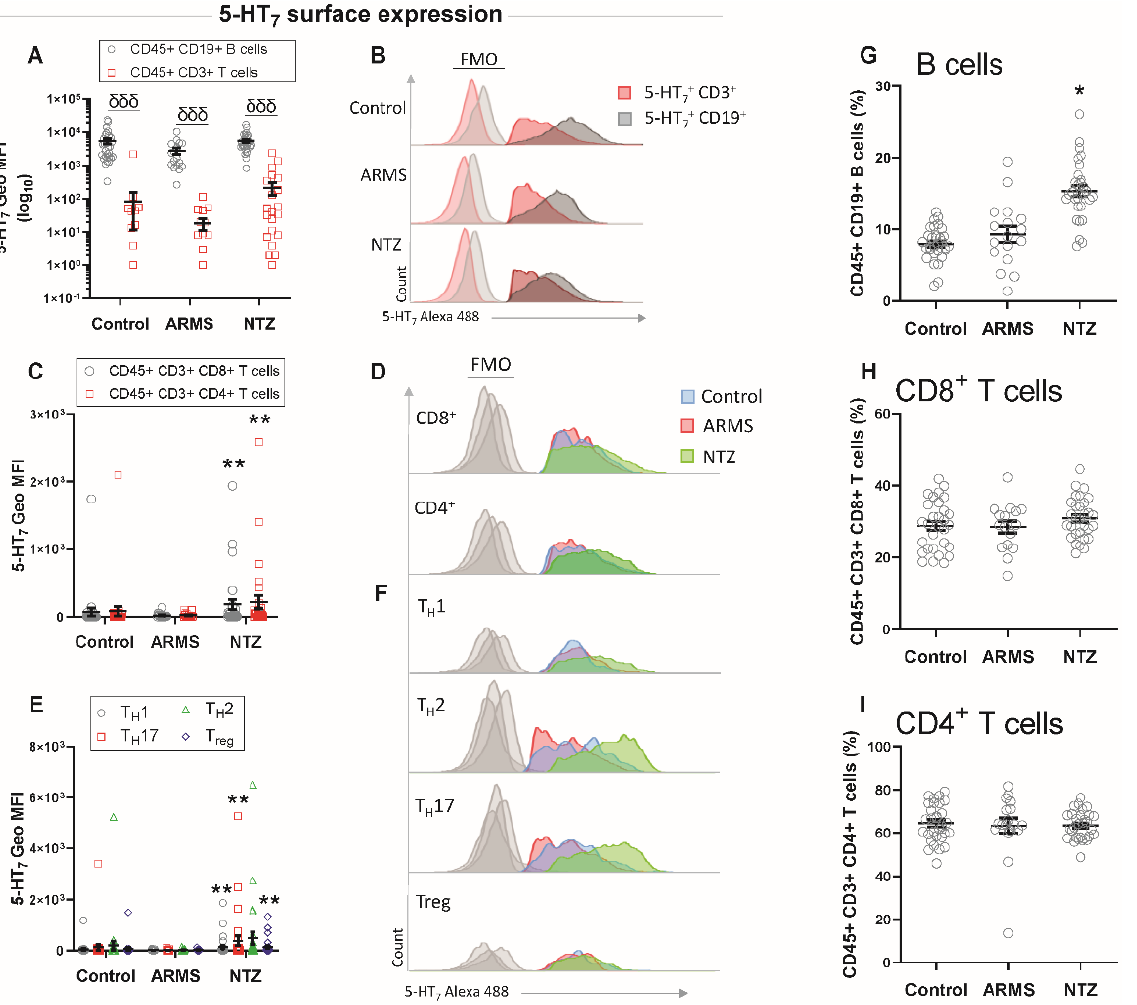
Figure 2. 5-HT 7 expression level on the surface of circulating lymphocytes from control, ARMS, and NTZ patients. Geometric mean fluorescence intensity (Geo MFI) of 5-HT 7 surface expression and histogram representation of the cytometry analysis on CD45 + CD19 + B and CD45 + CD3 + T lymphocytes ( A , B ), on CD3 + CD8 + and CD3 + CD4 + T cells ( C , D ), and CD4 + T cell subsets ( E , F ). Proportions of circulating cells analyzed by flow cytometry are shown for B cells ( G ), CD8 + ( H ), and CD4 + T cells ( I ) from control, ARMS, and NTZ patients. Results are given as mean ± SEM. B cells compared with T cells for each gr oup. *: compare with control. δδδ p < 0.001; * p < 0.05; ** p < 0.01.